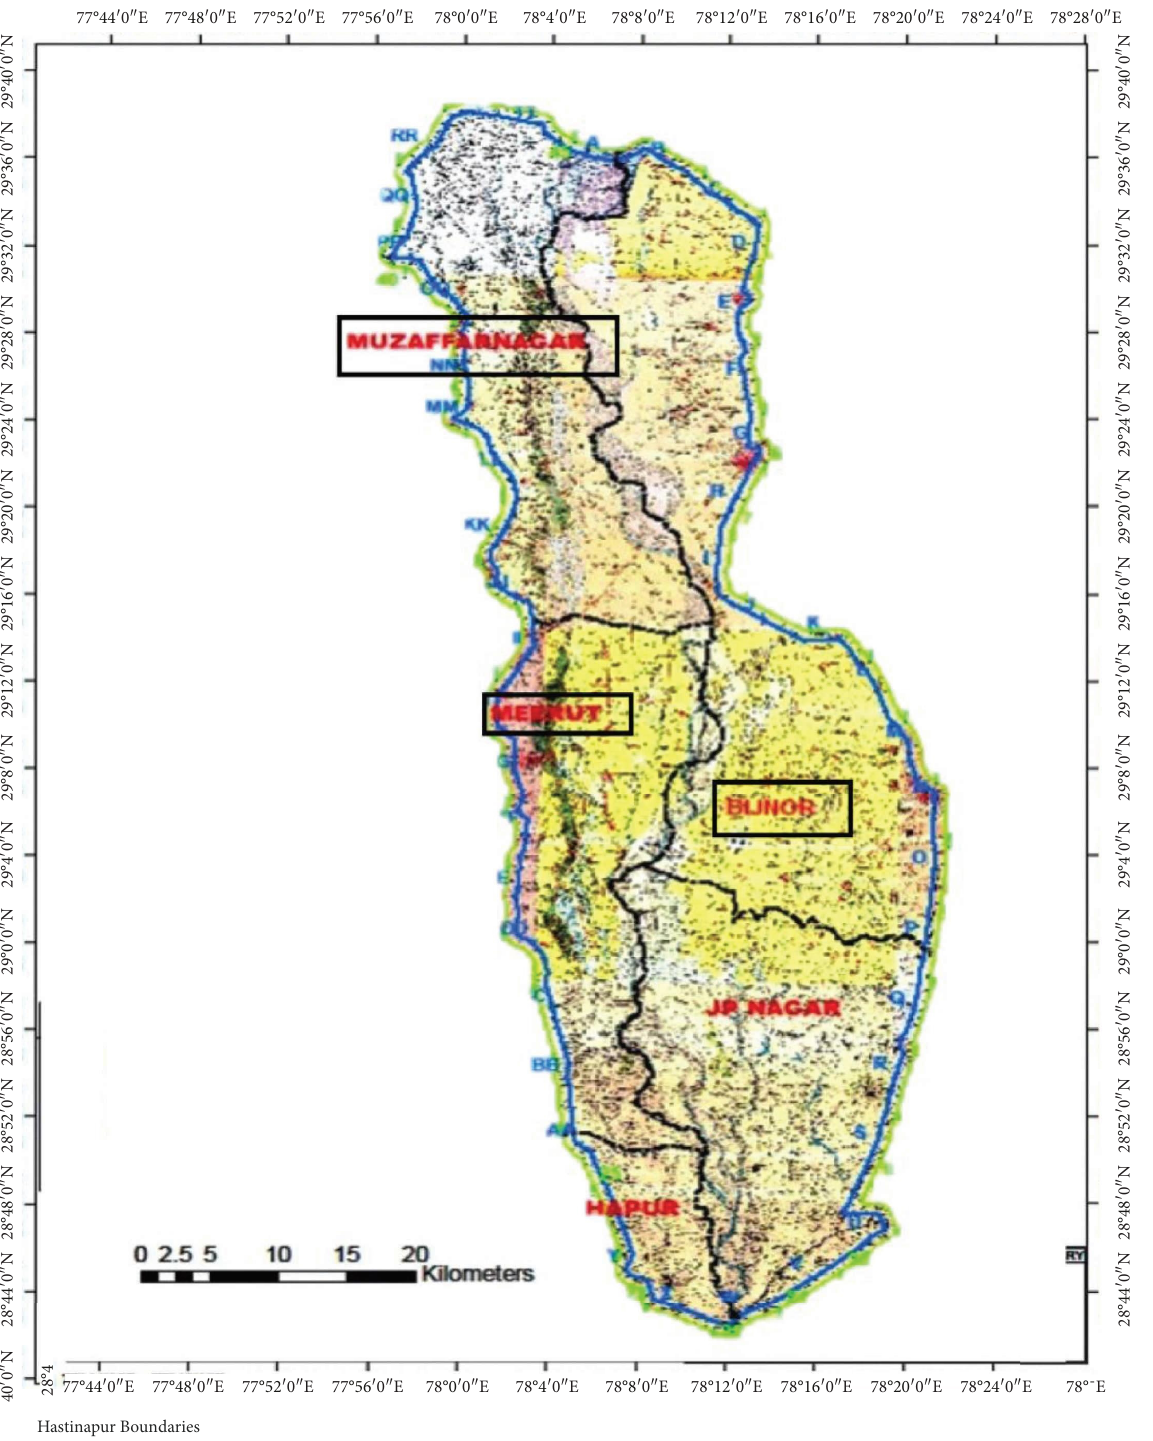
Figure 10: Map of the eco-sensitive zone of Hastinapur on the survey of India (Adopted from Te gazette of India: extraordinary [Part II, Page 30; Section 3(ii)] Annexure-